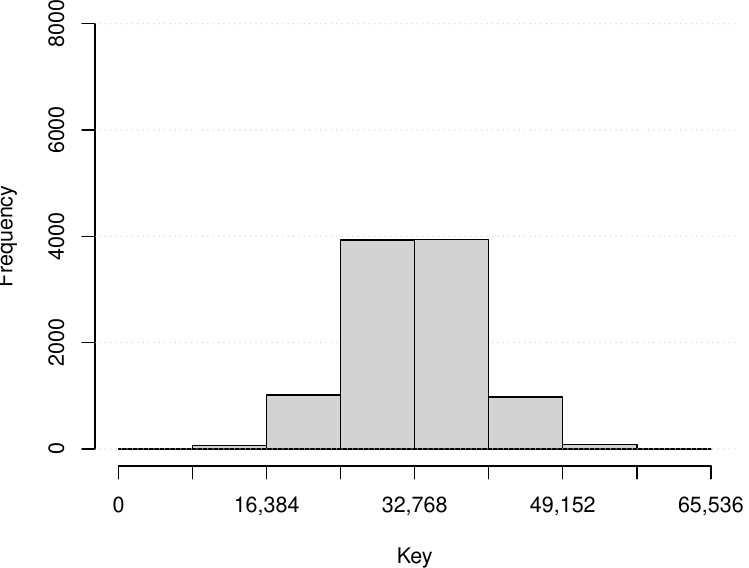
Figure 7. The number of messages among virtual nodes for one query.